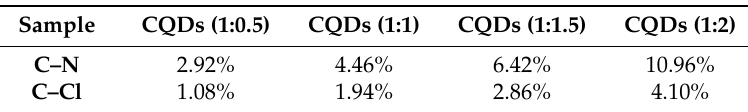
Table 1. Intensity proportion of C–N and C–Cl in the C 1s spectra of CQDs (1:0.5), CQDs (1:1), CQDs (1:1.5) and CQDs